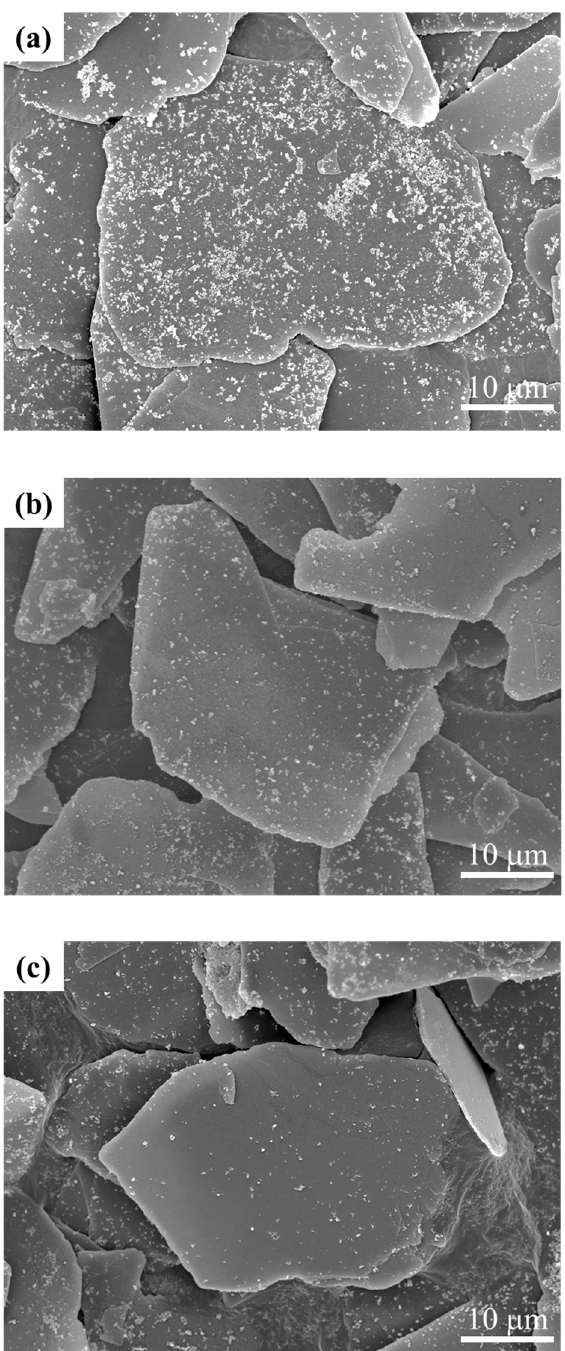
Figure 9. FE-SEM images of Y 2 O 3 :Eu@MF prepared at the following calcination temperatures: ( a ) 650 °C, ( b ) 750 °C, and ( c ) 850 °C, with the synthetic condition in Figure 8b.